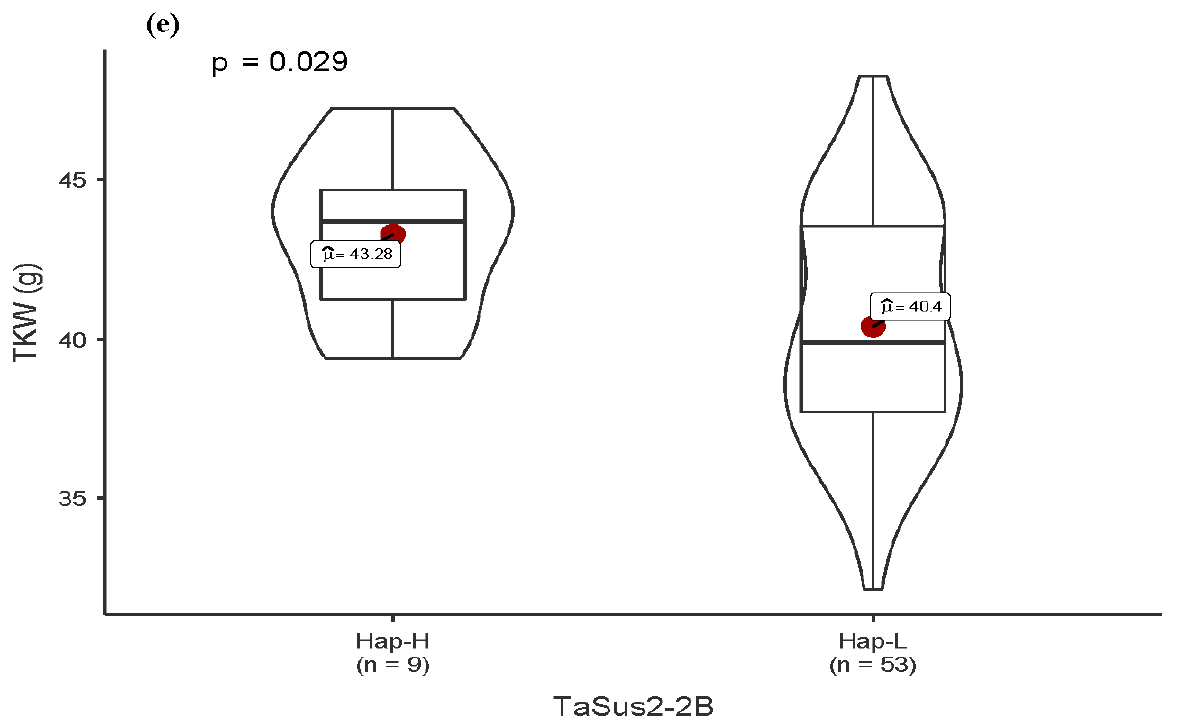
Figure 4. Allelic effects of Rht-1 haplotypes on grain Fe ( a ), grain Zinc ( b ), plant height ( c ), grain yield ( d ) and TaSus2-2B gene on thousand kernel weight (TKW) ( e ) in historical wheat cultivars of Pakistan.